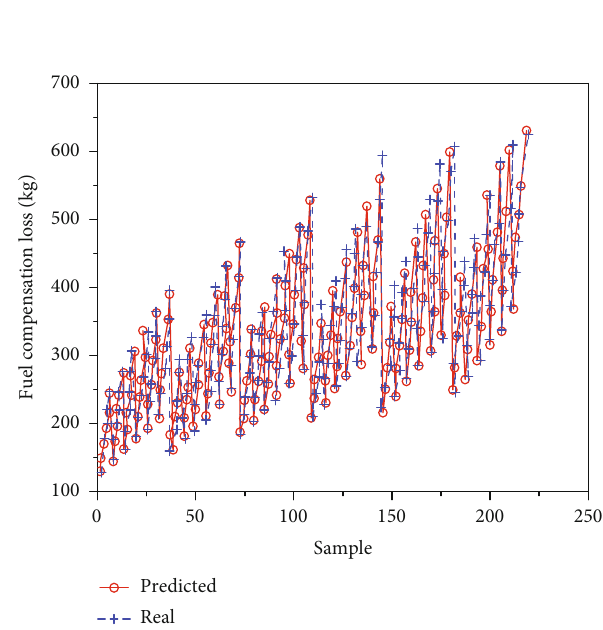
Figure 10: Comparison of predicted and calculated values of fuel penalty.